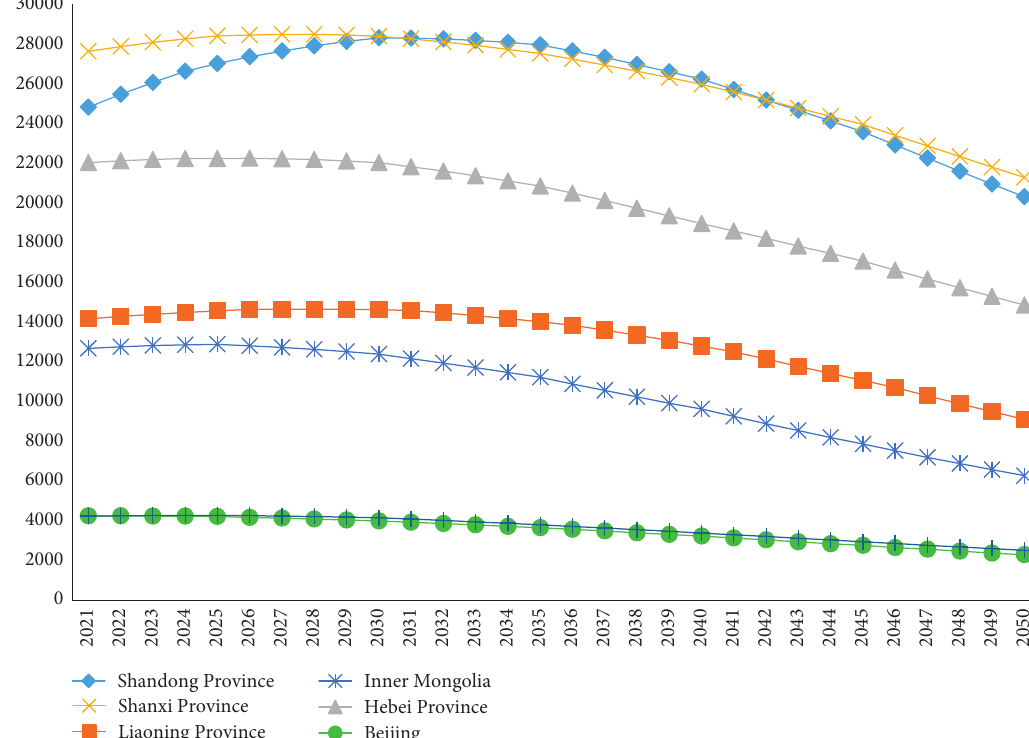
Figure 3: Carbon emissions of each province and city under the 2000–2020 scenario (unit: 10,000 tons).